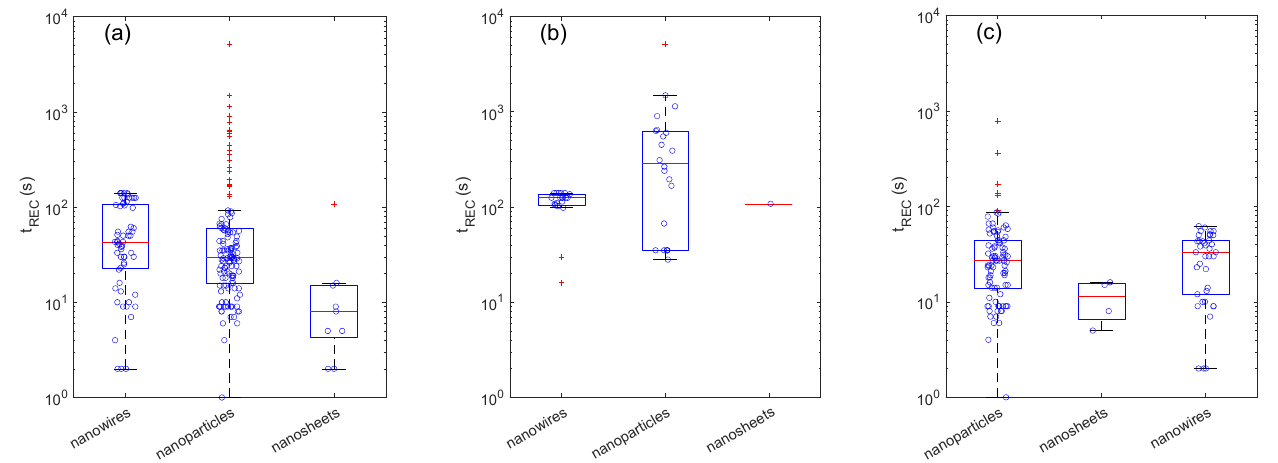
Figure 5. Effects of crystallite morphology on recovery times (t REC ). Boxplots showing the distribution of t REC for different crystallite morphologies for the whole set of measurements ( a ) and for the sub-set of measurements carried out with dynamic ( b ) and static ( c )